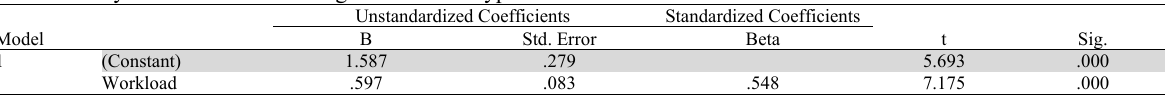
The summary of the results of testing the first sub-hypothesis